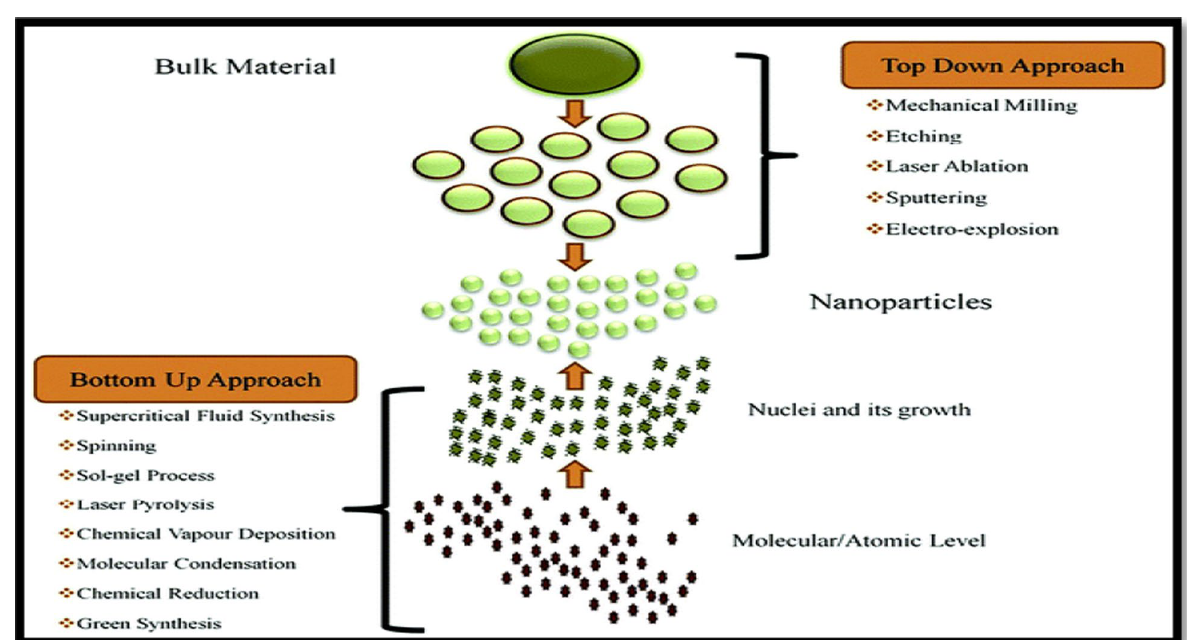
Fig. 2 The synthesis of nanomaterials via top-down and bottom-up approaches (Baig et al. 2021)